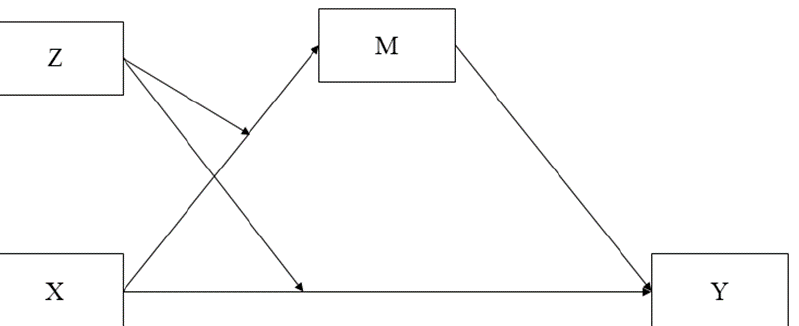
Figure 1. Conceptual model of conditional indirect effects. Model representing X as a predictor, Z as a moderator, M as a mediator, and Y as a dependent variable.